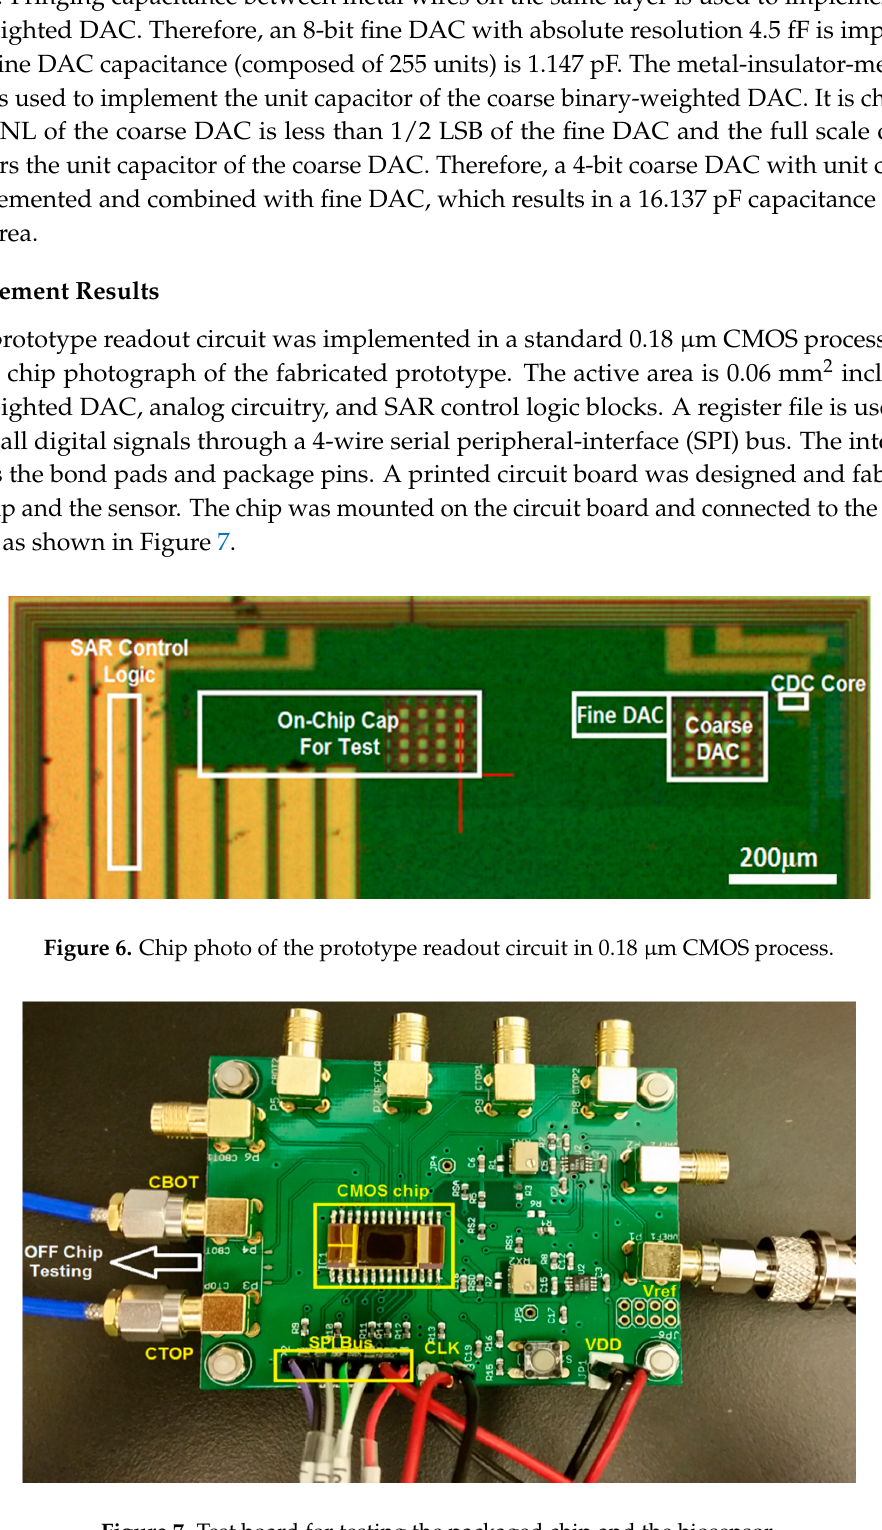
Figure 7. Test board for testing the packaged chip and the biosensor.